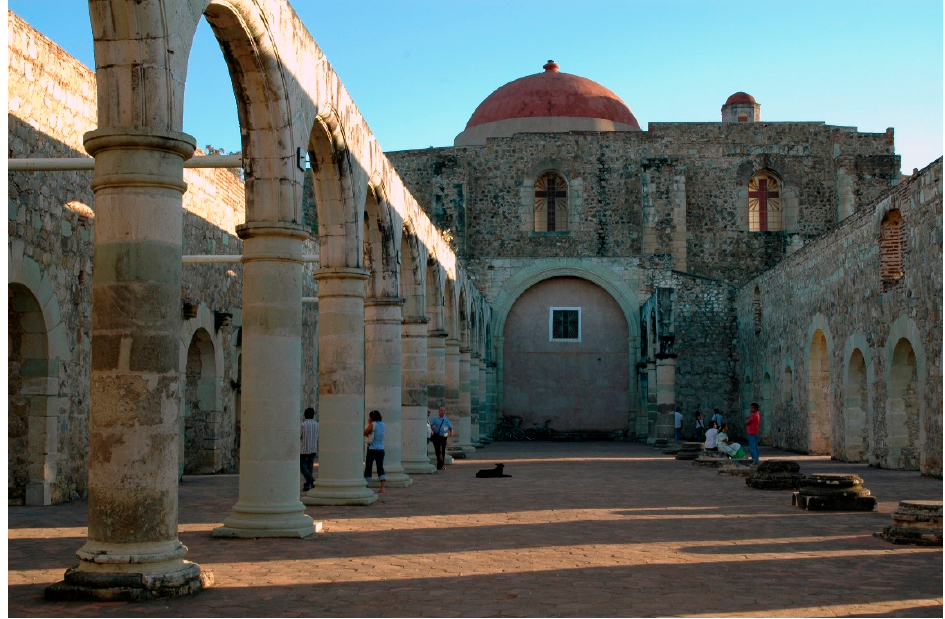
Figure 7. Interior of Santiago Apostol church. Cuilapan. Photo took by author.